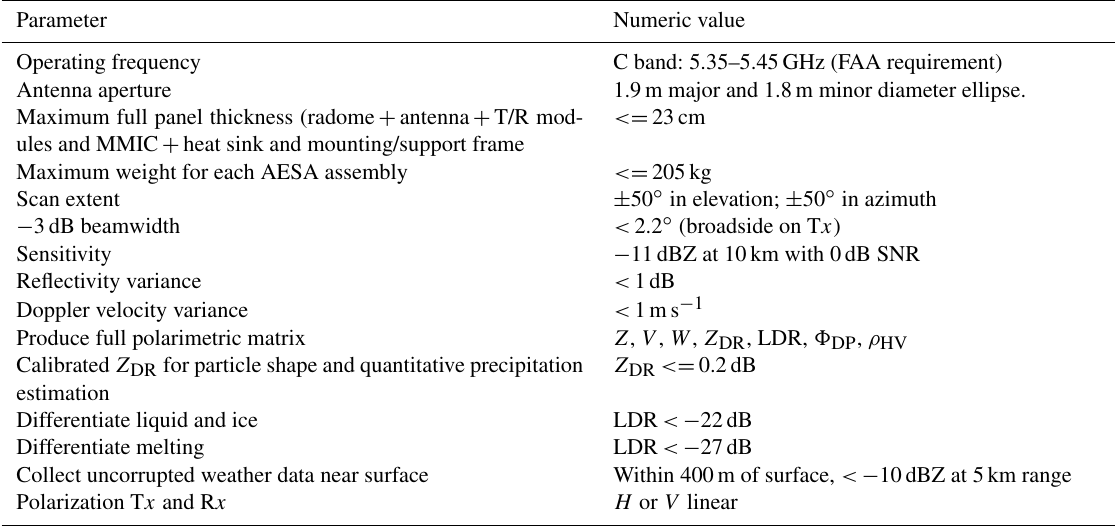
Table 1. Technical specifications of C-band